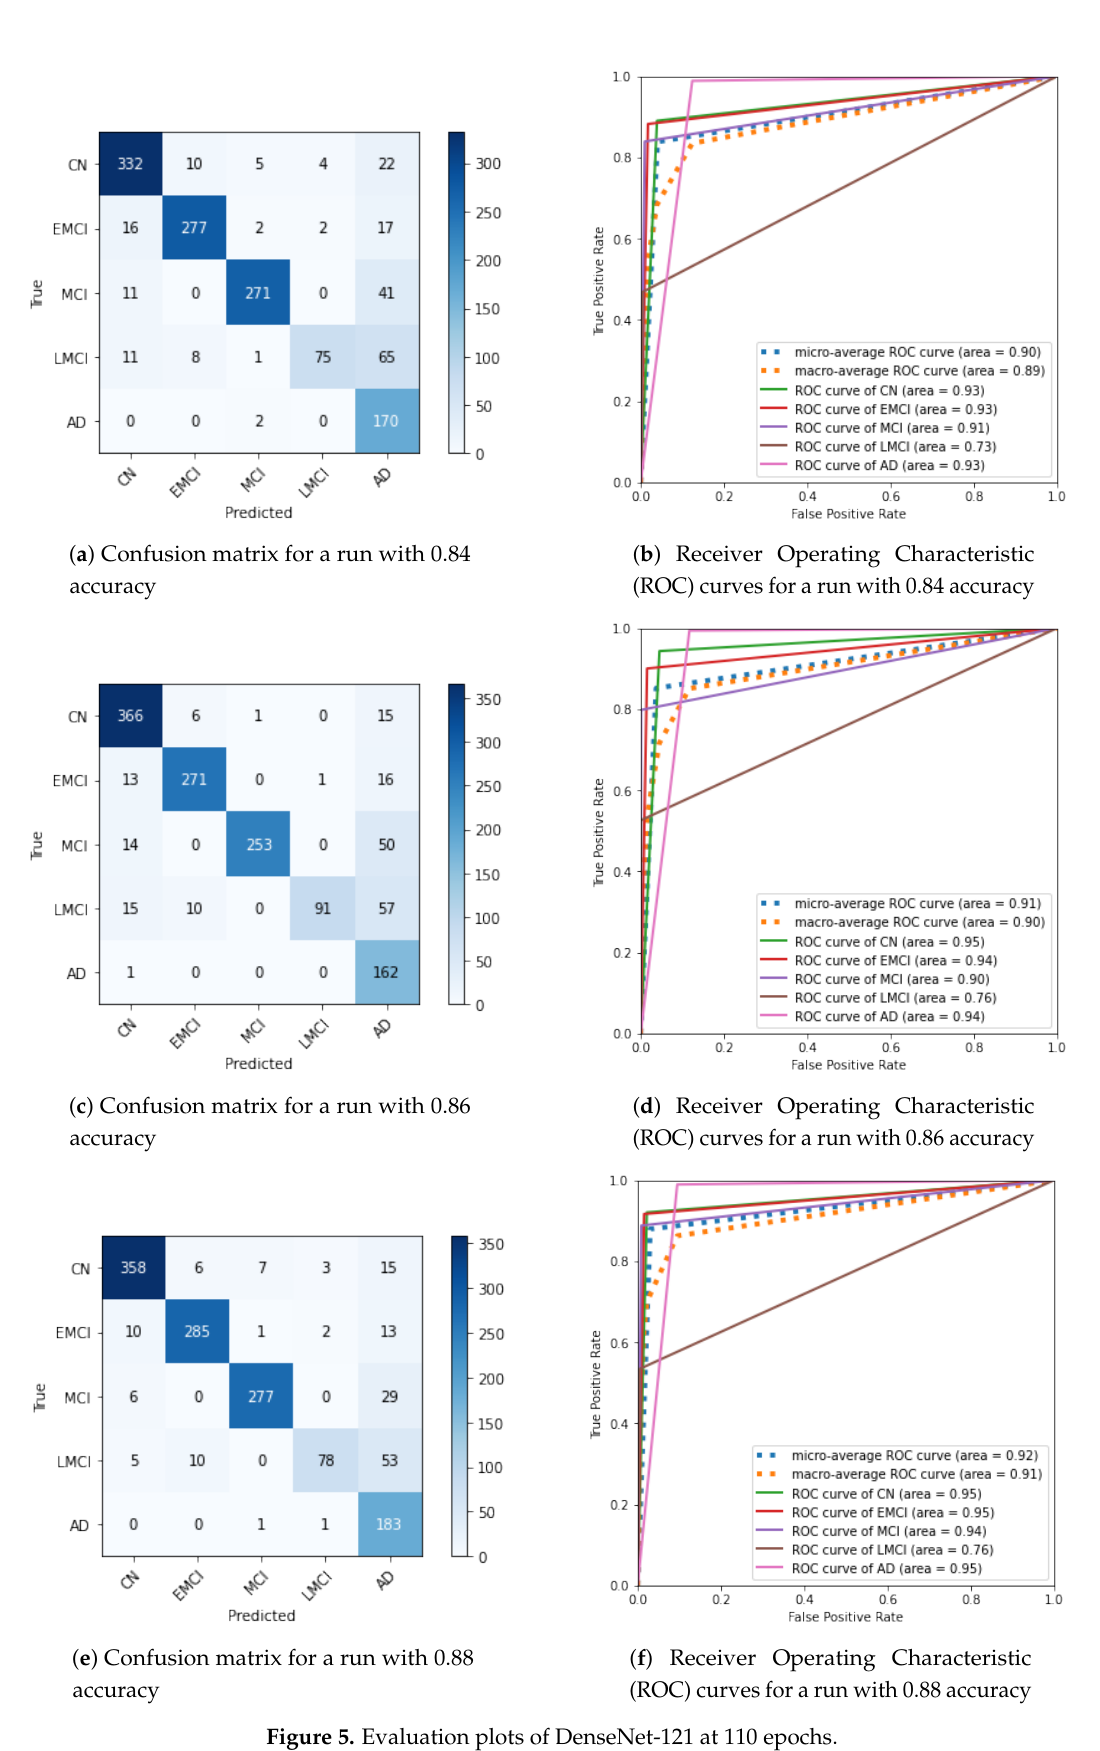
Figure 5. Evaluation plots of DenseNet-121 at 110